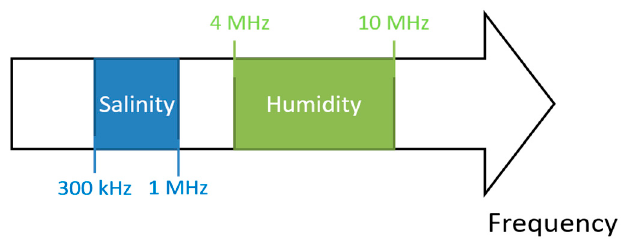
Figure 17. Dedicated frequency ranges for single shape sensor (salinity or humidity).